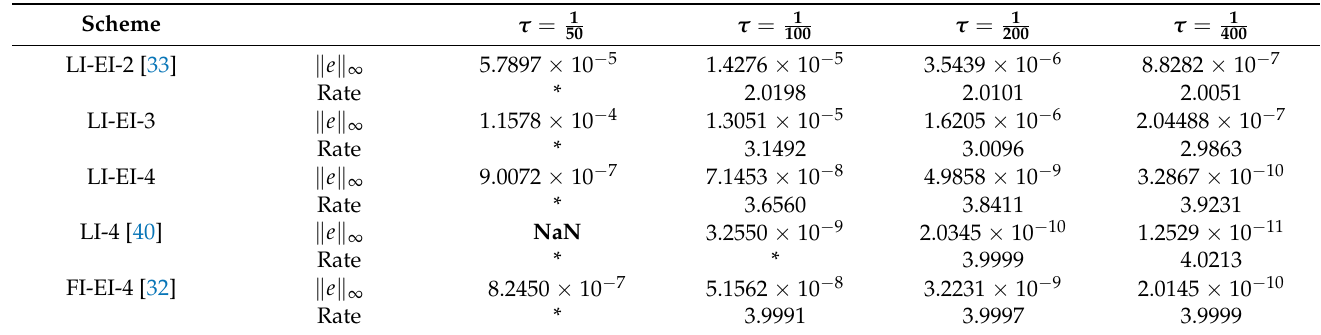
Table 2. Temporal accuracy of different schemes with α = 1.8, β = − 0.05, h = π